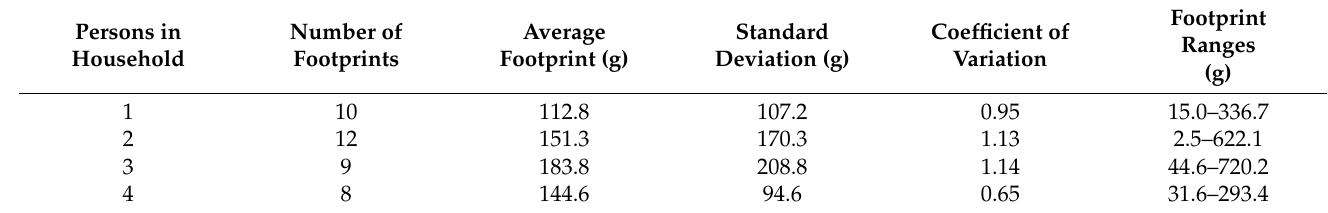
Table 3. Potential endocrine-disrupting compound (EDC) footprint reduction that could be achieved by replacing the top five contributing products with a greener alternative for one example user. Table 4. Summary by household size of endocrine-disrupting compound (EDC) footprint calculator results from 39 citizen scientists. Summary results include the average footprint per household